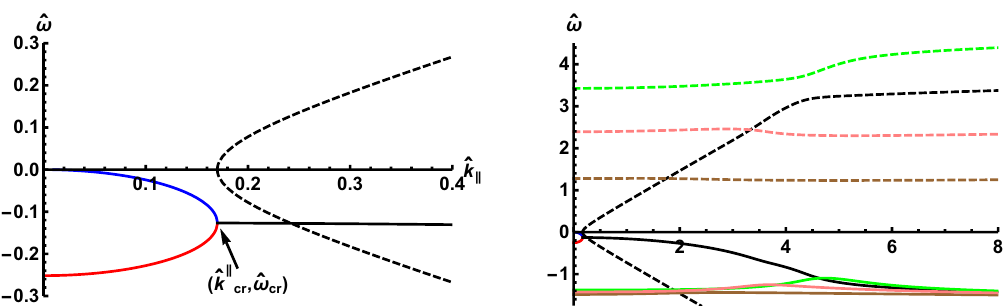
Figure 5 . We display the typical dispersion relations for the in-plane case (o(cid:11)-plane is qualitatively the same) at ^ d = 10. The solid curves denote imaginary parts while dashed curves are real parts of the modes. On the right panel we extend the range of ^ k and notice that the zero sound collides k with complex modes, eventually leading to